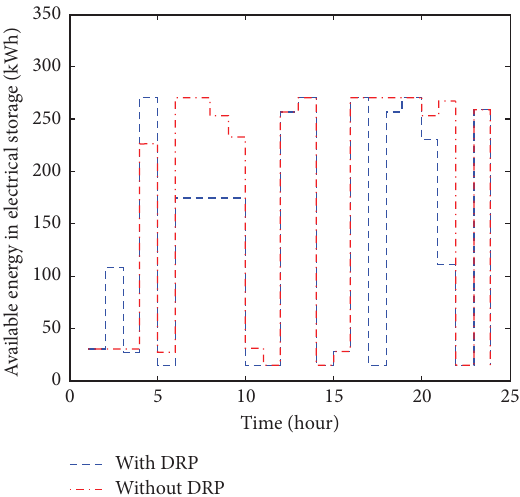
Figure 18: Te energy stored in the electrical storage.